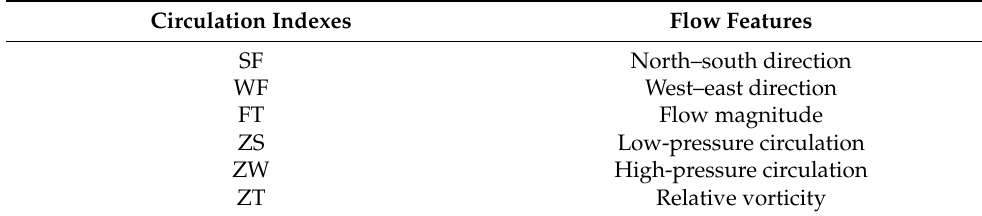
Table 2. Classification indexes. Adapted from [32].